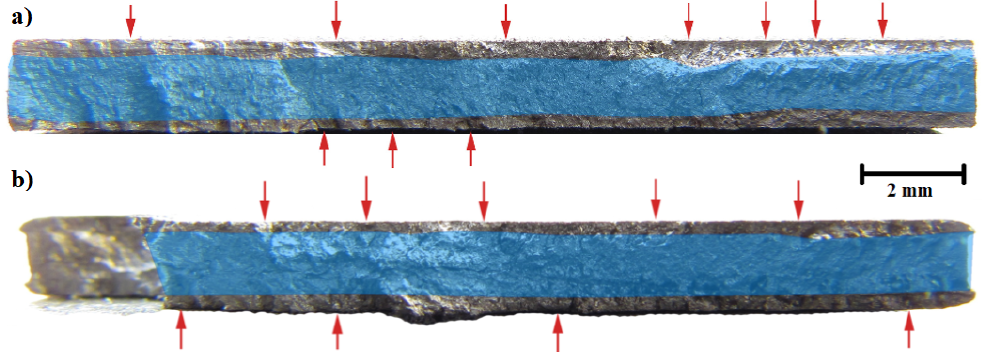
Figure 8. Fracture surfaces of the heat treated ( a ) and severe shot peened after heat treatment ( b ) samples. Red arrows indicate fracture initiation sites, and the blue areas are estimates of the final fracture